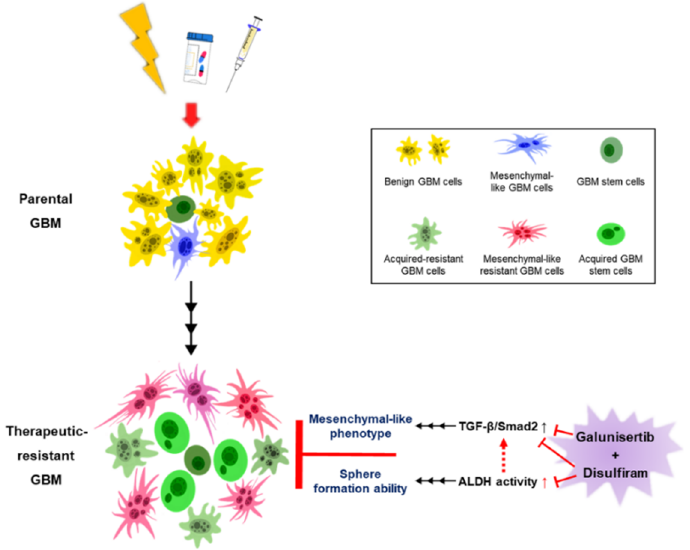
Figure 10. Summary of the activation of TGF-β-induced mesenchymal-like phenotype and ALDH in therapeutic resistance in GBM. Dotted red arrow means the potential interplay between ALDH activity and TGF-β/Smad2 signaling; the black solid up arrow means the development of therapeutic resistance or TGF- β /Smad2 signaling and ALDH activity-induced phenotypes; the red solid up arrow means therapeutic resistance-increased ALDH